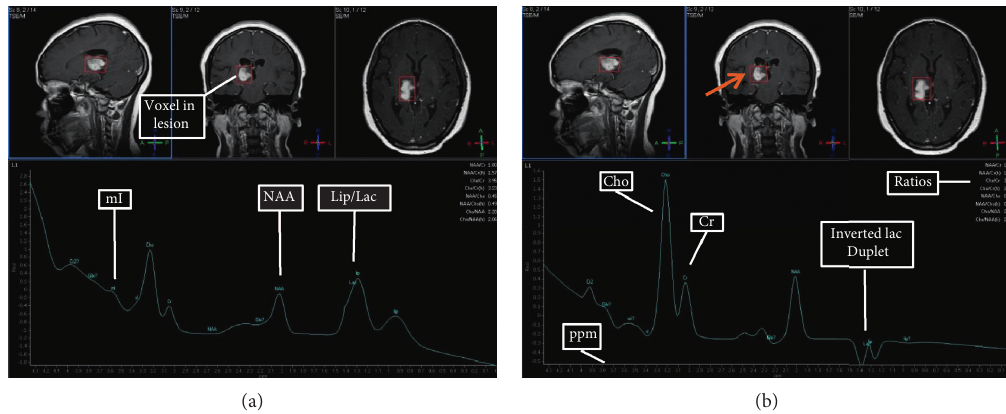
Figure 5: (a) TE 31 msec. (b) TE 144 msec. MRS was performed to differentiate between high-grade and low-grade glioma. The lesion was diagnosed as a high-grade glioma. NAA is decreased. Lipid and lactate are increased. Choline is markedly elevated. Cho :Cr ratio is 2.93, and Cho :NAA ratio is 2.44. At TE31, myo-inositol is reduced. Myo-inositol decrease has been associated with high-grade gliomas (58).